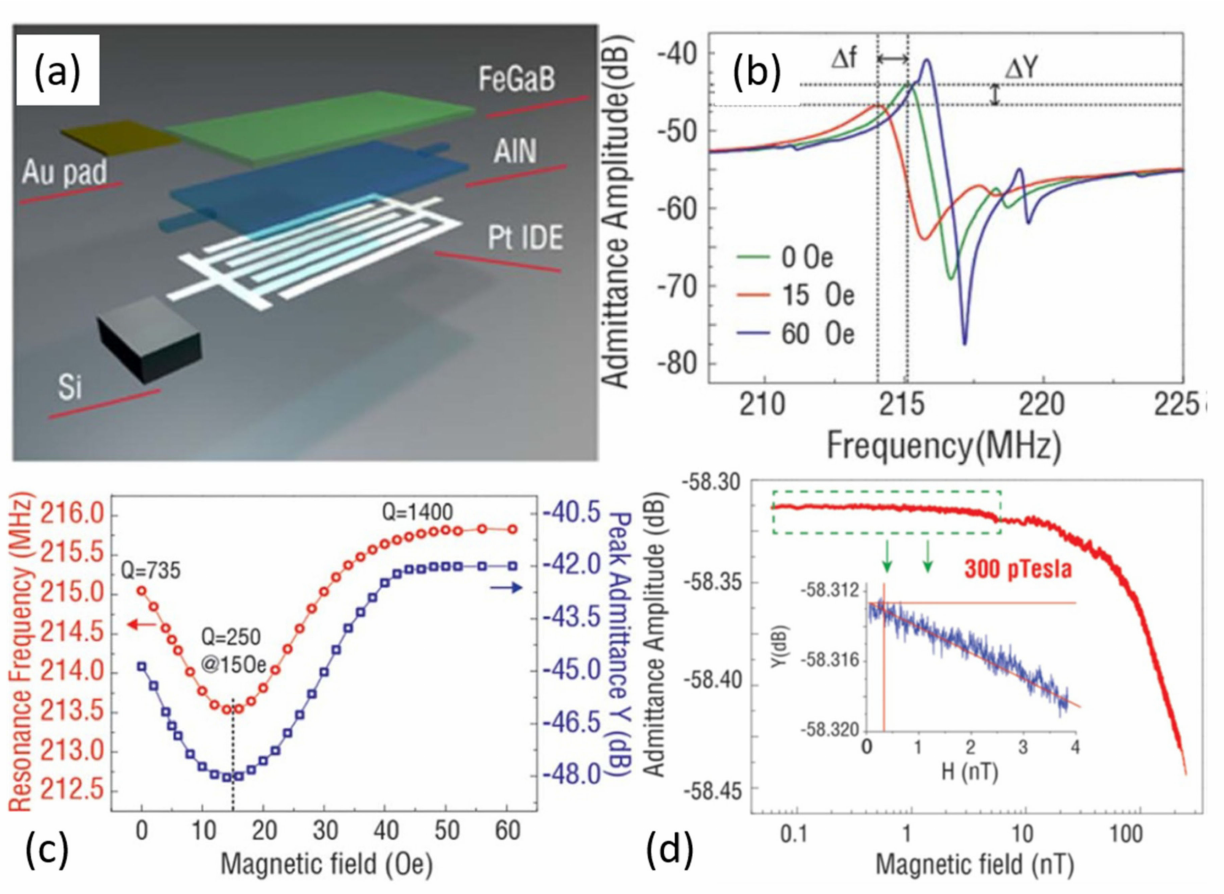
Figure 7. ( a ) Schematic illustration of the NEMS sensor. ( b ) Admittance curve of the NEMS sensor at various H dc . ( c ) H dc dependence pf the f r and admittance amplitude. ( d ) The sensitivity of the magnetic field sensor. The inset shows the zoomed in part from 50 pT to 4 nT. Reprinted with permission from ref. [39]. Copyright 2021 Springer Nature